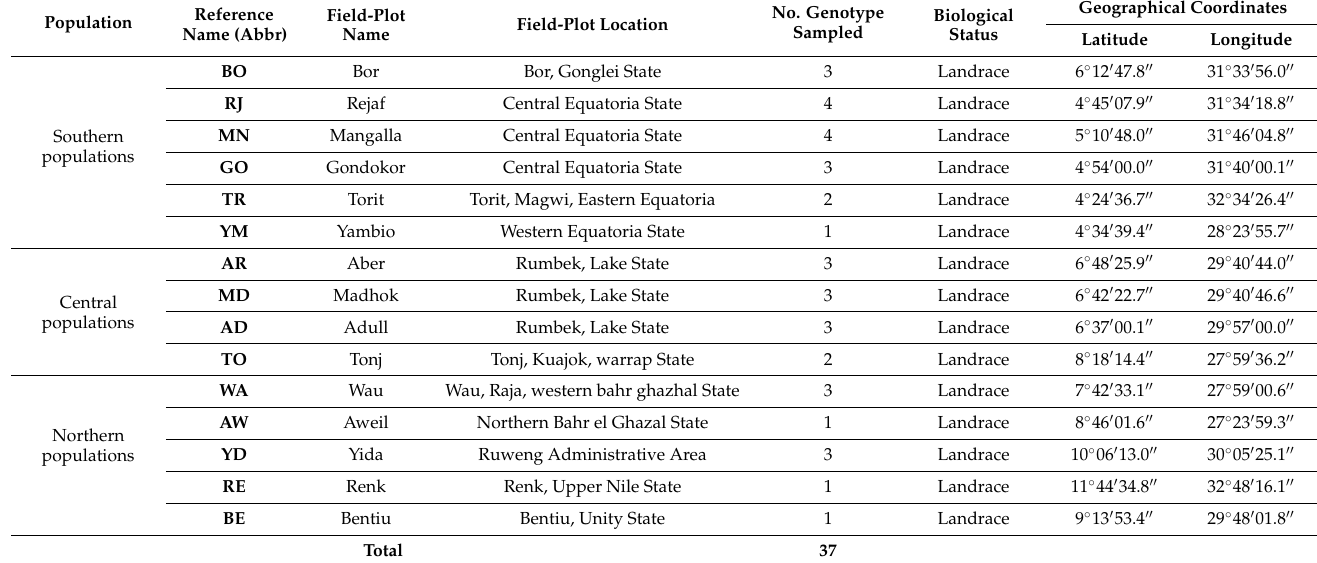
Table 3. Genetic diversity parameters of 15 maize landrace populations characterized with 27 SSR markers.